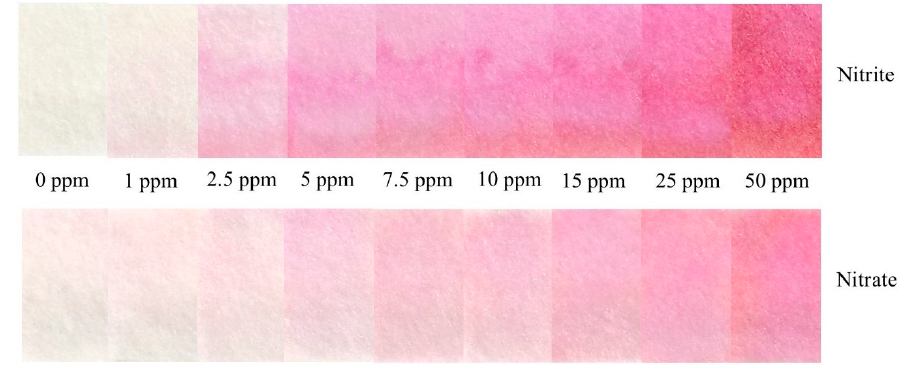
Figure 7. A color chart showing the evolution of color formation with increase in concentration .